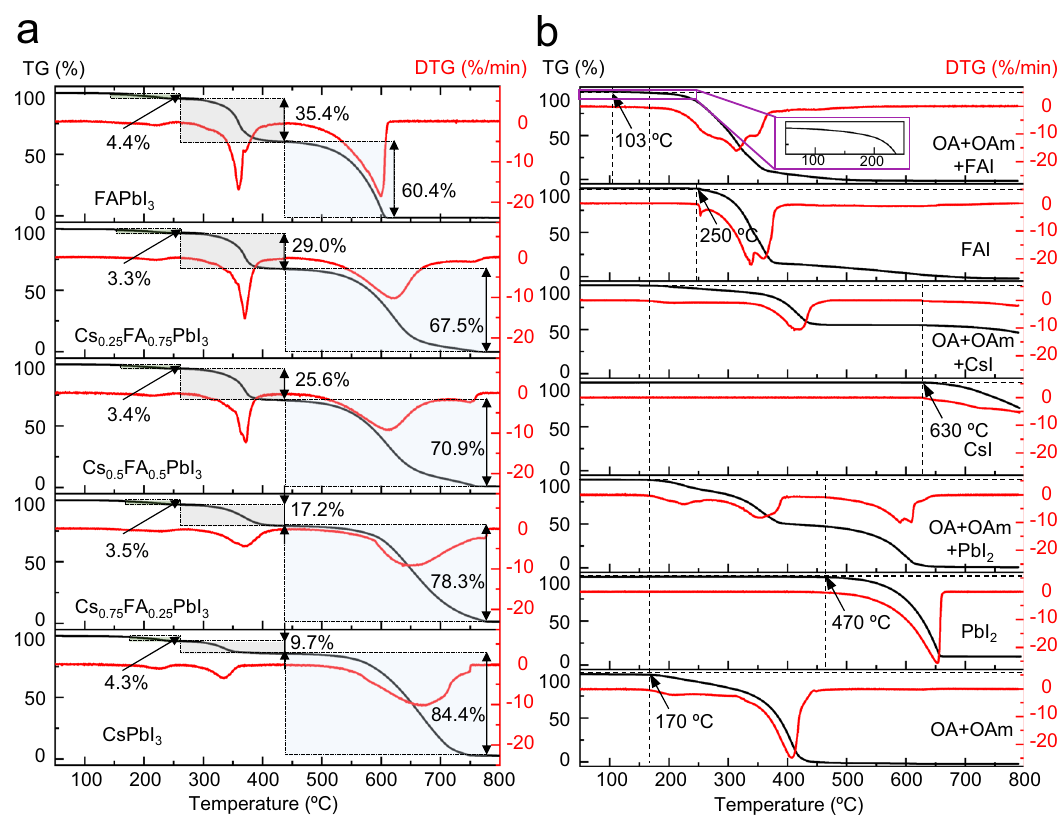
Fig. 3 | Mass loss for thermal degradation analyses of Cs x FA 1-x PbI 3 PQDs. a TG and DTG curves for Cs x FA 1-x PbI 3 PQDs with different FA/Cs ratios. The shading representsthepercentageofmasslossintherelevanttemperaturerange. b TGand DTGcurvesforthepureFAI,CsI,PbI 2 andthemixturesofOA+OAm,CsI+OA+OAm,